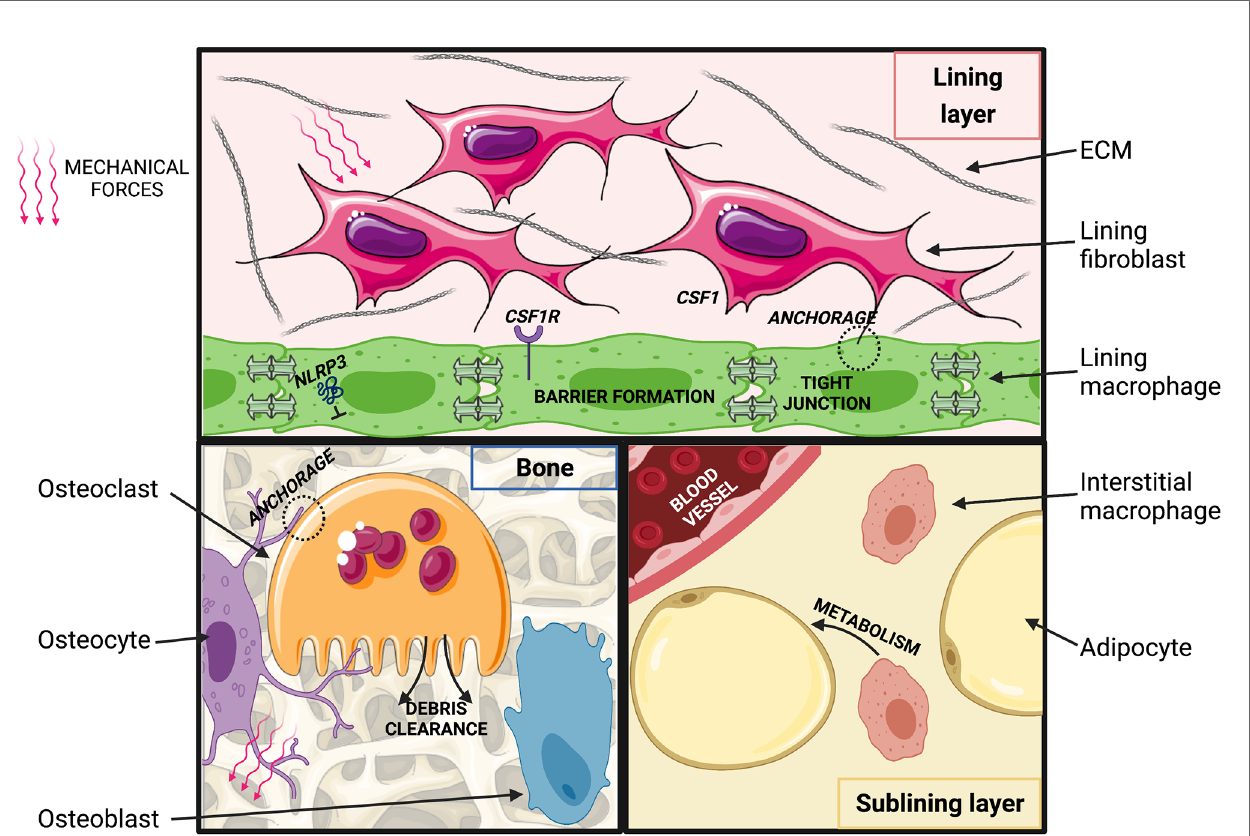
FIGURE 2 | Putative macrophage niches in the healthy joint. (Top) Synovial lining: macrophages are connected via tight junctions and are in close contact with fi broblasts. Fibroblasts may provide CSF1 and anchorage to macrophages, which may be imprinted by exposure to ECM degradation products. Movement-induced cyclic stretch may inhibit NLRP3 in fl ammasome activation. (Bottom, left) Osteoblasts lining the bone surface synthesize bone matrix in response to soluble mediators released by osteocytes that sense changes in mechanical loading and bone deformation. Osteoclasts resorb bone and thereby regulate balanced homeostatic bone turnover ( “ modelling ” ) in response to anchorage and soluble signals from osteocytes and osteoblasts. (Bottom, right) In the synovial sub-lining, self-maintained interstitial macrophages may regulate adipose tissue metabolism and act as a reservoir to replenish synovial lining macrophages. Created with BioRender.com and